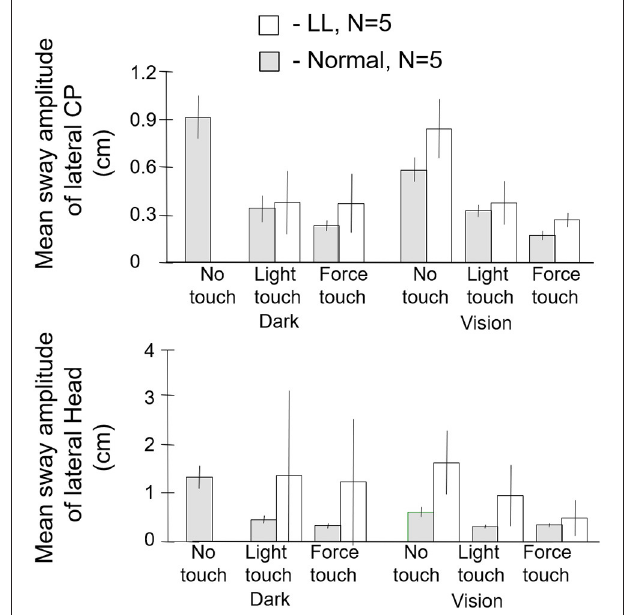
FIGURE 8 | Mean sway amplitude of center of pressure (CP), top panel, and of head, bottom panel of labyrinthine loss (LL), N = 5 and normal subjects, N = 5. There are no entries in the dark no-touch conditions for the LL subjects because they lose balance within several seconds. With light touch in the dark, the LL subjects have a significantly lower CP mean sway amplitude than the normal subjects in their no-touch vision